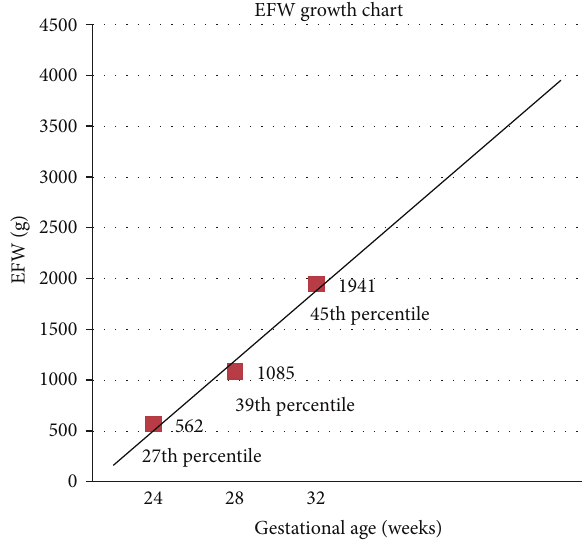
Figure 1: EFW: Estimated Fetal